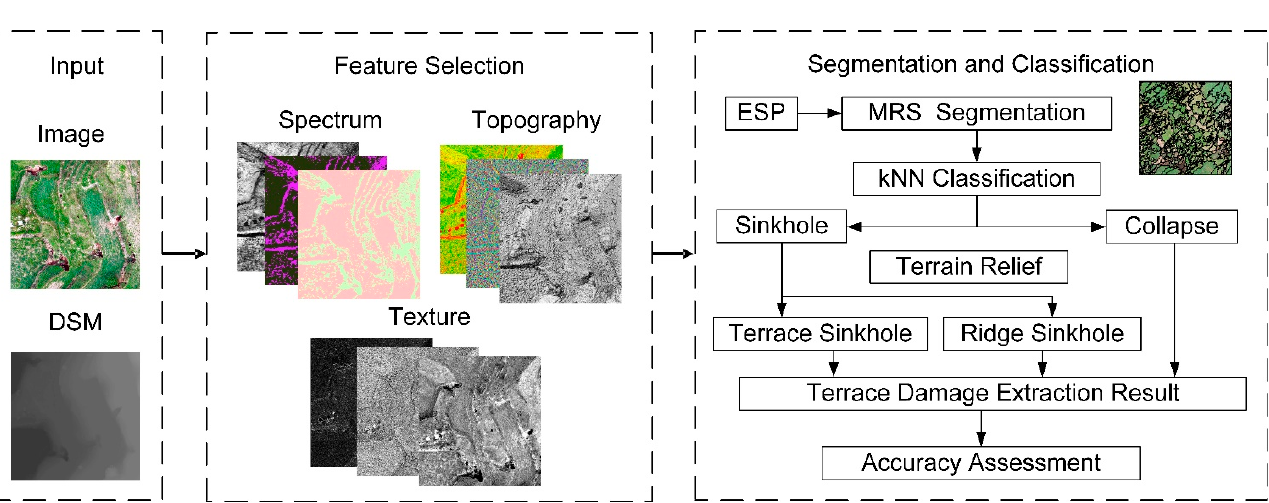
Table 1. Overview of the features used for segmentation.